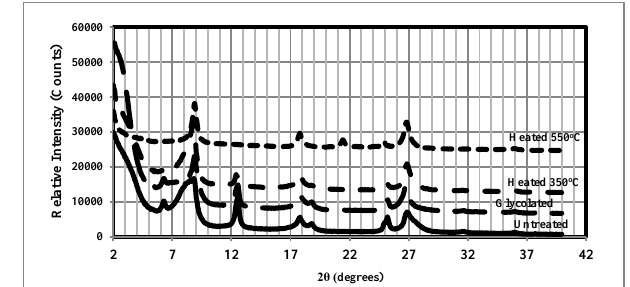
Figure 2: X-ray diffractograms of sample from Outcrop 1 (Scans R